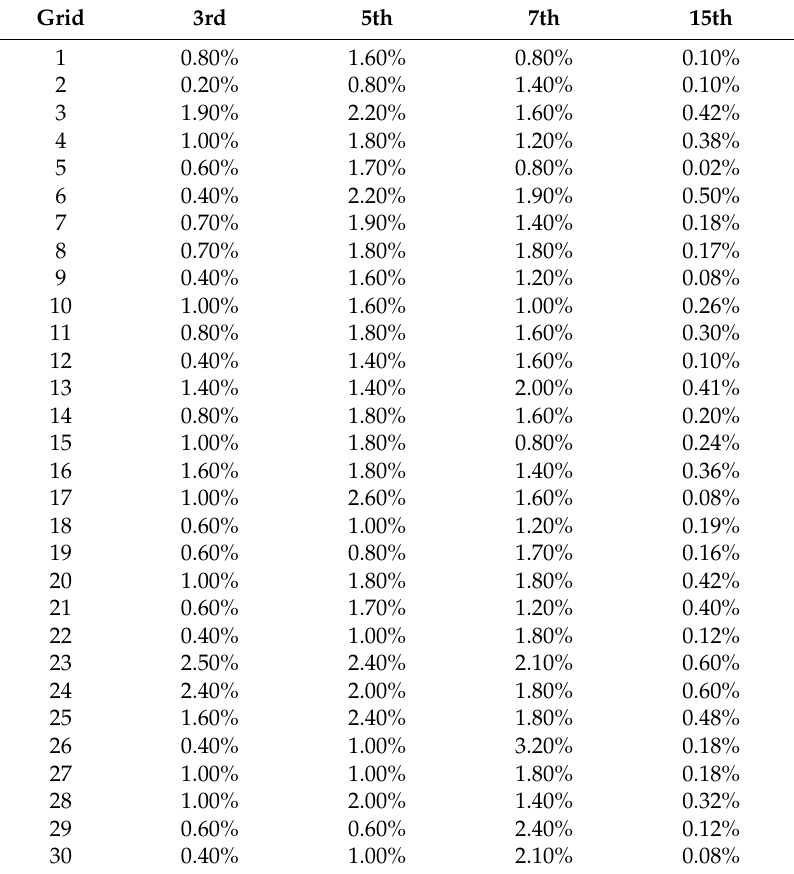
Table 3. Evaluation of the voltage harmonic from